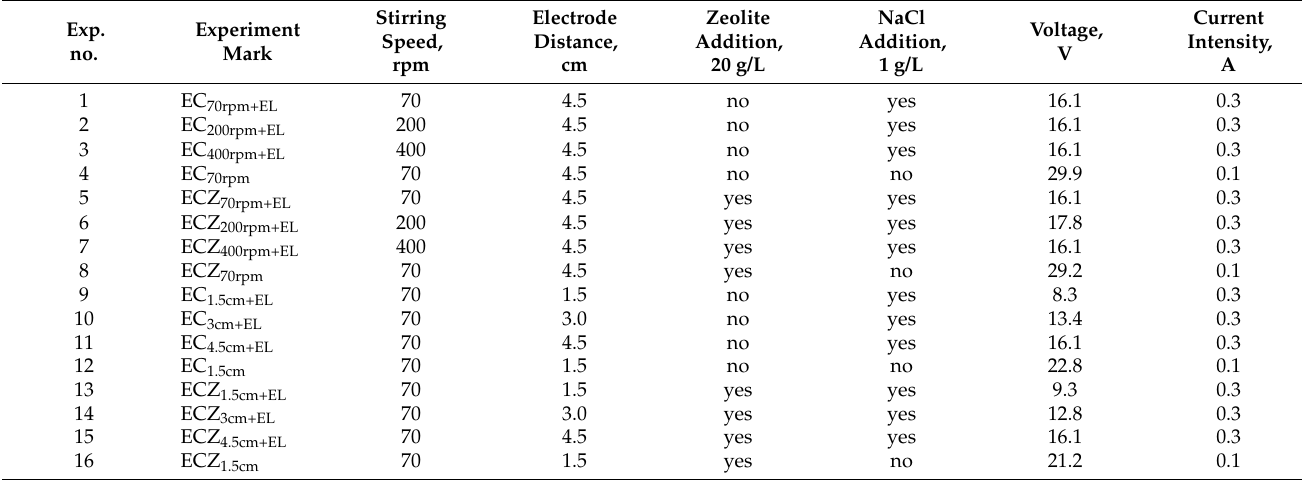
Table 1. Overview of experimental conditions during experiments.